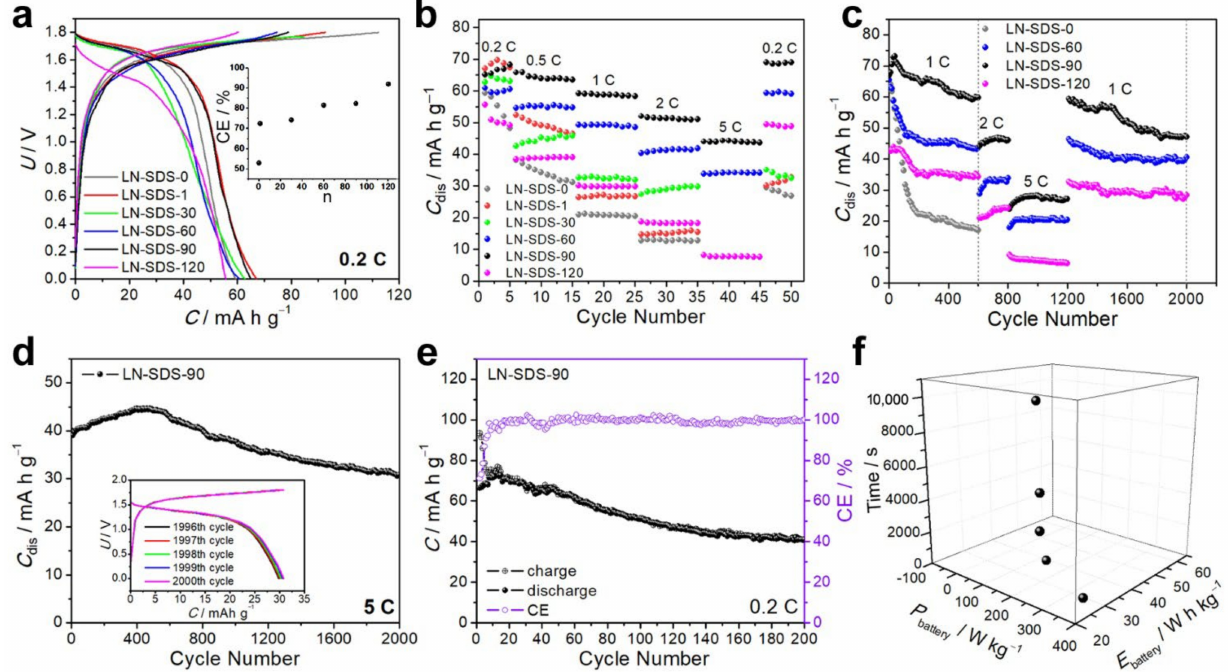
Figure 5. Electrochemical performance of NTP (cid:107) LMO operating with LN-SDS-n at room temperature: ( a ) GCD curves, ( b ) rate capability, ( c ) cycling performance at varying C rates, ( d ) cycling performance at 5 C, ( e ) cycling performance at 0.2 C, and ( f ) Ragone